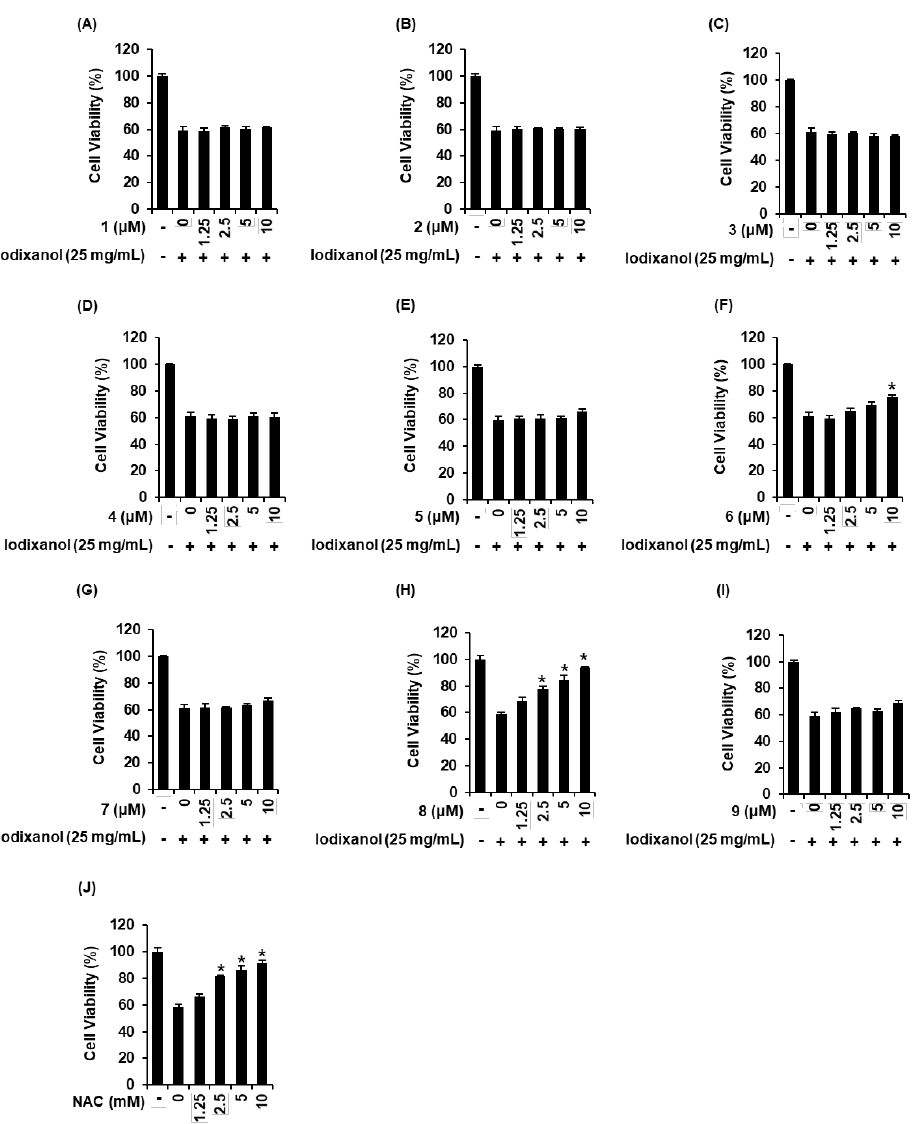
Figure 3. Comparison in the protective e ff ects of nine sesquiterpenes isolated from Artemisia argyi on iodixanol-induced cytotoxicity in LLC-PK1 cells. ( A – J ) Cells were exposed to 25 mg / mL iodixanol in the presence or absence of nine sesquiterpene compounds including ( A ) moxartenolide (compound 1 ), ( B ) dehydromatricarin A (compound 2 ), ( C ) tuberiferin (compound 3 ), ( D ) argyinolide G (compound 4 ), ( E ) deacetylmatricarin (compound 5 ), ( F ) rupicolin A (compound 6 ), ( G ) acrifolide (compound 7 ), ( H ) 3- epi -iso- seco -tanapartholide (compound 8 ), and ( I ) iso- seco -tanapartholide (compound 9 ) and ( J ) N-acetyl cysteine (NAC) and cell viability was measured using an Ez-Cytox cell viability assay kit (mean ± SD, n = 3, * p < 0.05 compared with iodixanol-treated LLC-PK1 cells).